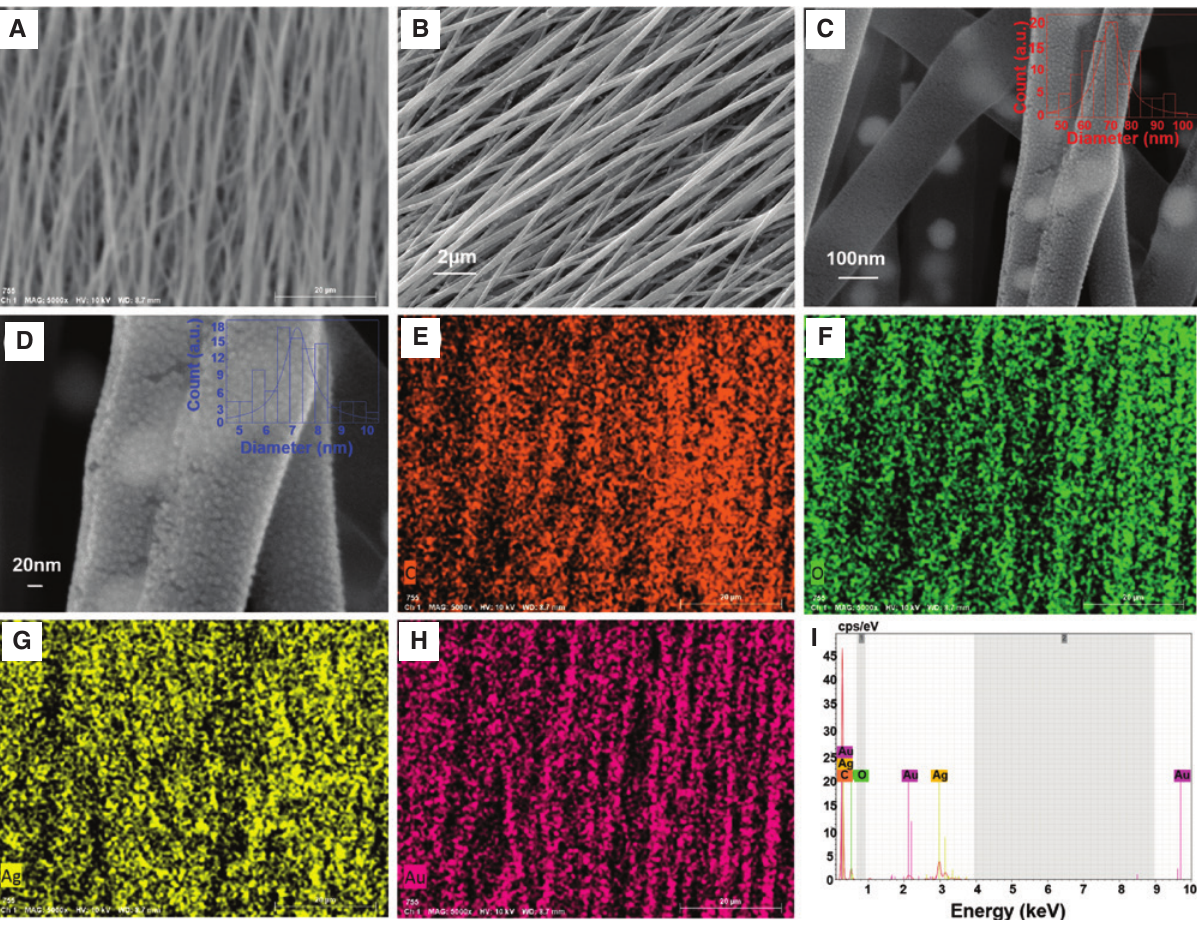
Figure 4: Structural characterization for AgNPs/PVA@Ag nanofibers. (B–D) SEM images of AgNPs/PVA@Ag nanofibers electrospun hybrid films with different enlargement factor. EDS elemental maps from (E) C, (F) O, (G) Ag, (H) Au on the (A) AgNPs/PVA@Ag nanofibers substrate. (I) The EDS of the AgNPs/PVA@Ag